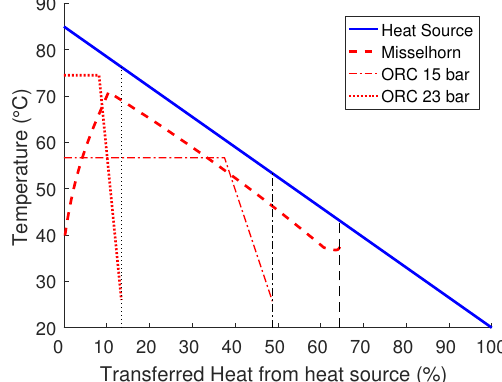
Figure 8. Comparison of two operating points of an ORC with the Misselhorn cycle (setup with six heat